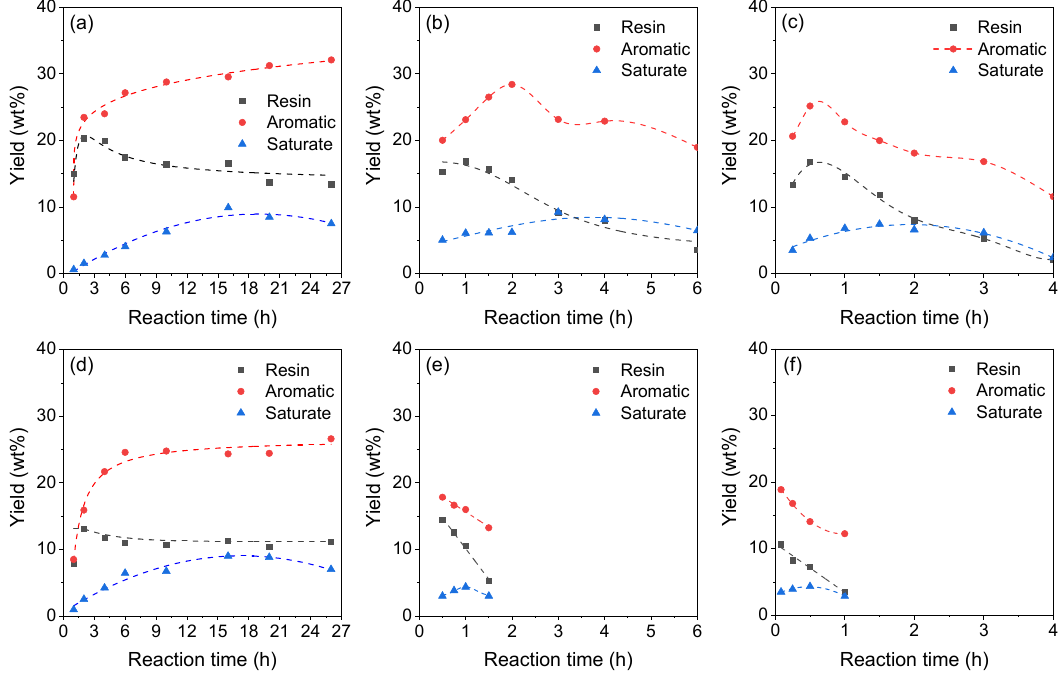
Figure 4. Yields for resins, aromatics, and saturates in catalytic hydrocracking of C5-Asp at ( a ) 380, ( b ) 410, and ( c ) 430 °C and non-catalytic hydrocracking of C 5 -Asp at ( d ) 380, ( e ) 410, and ( f ) 430 °C. Reaction conditions: batch reactor, P H2 = 80 bar at 80 °C, and 1000 wppm of Mo from Mo-octoate in catalytic hydrocracking.